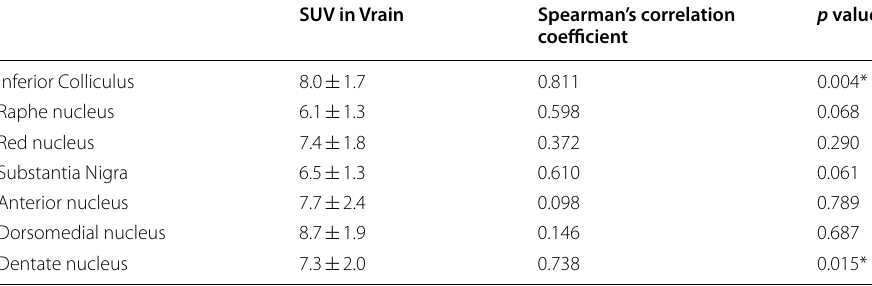
Table 1 SUVs of each small nucleus visually identified in Vrain images and the relationship between the SUVs and